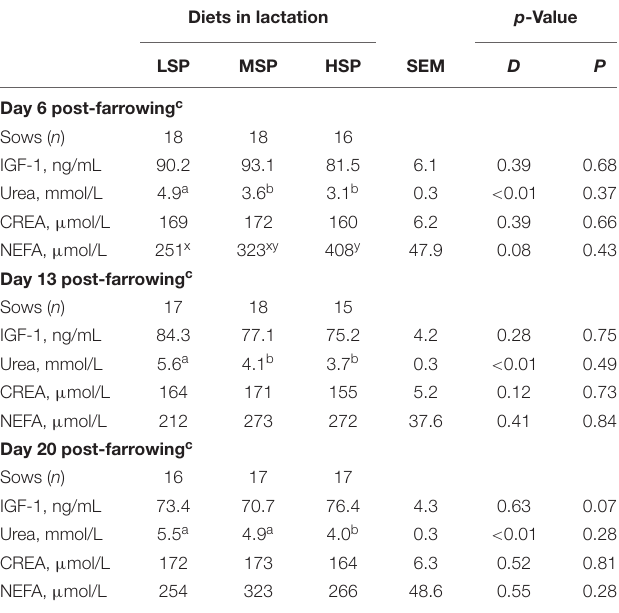
D, diet [LSP/MSP/HSP, where LSP, low level of slow protein diet (8%); MSP, medium level of slow protein diet (12%); HSP, high level of slow protein diet (16%); P, parity class (4/5, where 4 = sows in parity 3 and parity 4; 5 = sows in parity 5)]. a , b LS means within a row with different superscripts differ significantly at p < 0.05. x , y LS means within a row with different superscripts differ significantly at p < 0.1. c LSmeans compared in models with treatments and sow parity class as explaining variables. d LSmeans compared in mixed models with week as explaining variable and repeated measures.